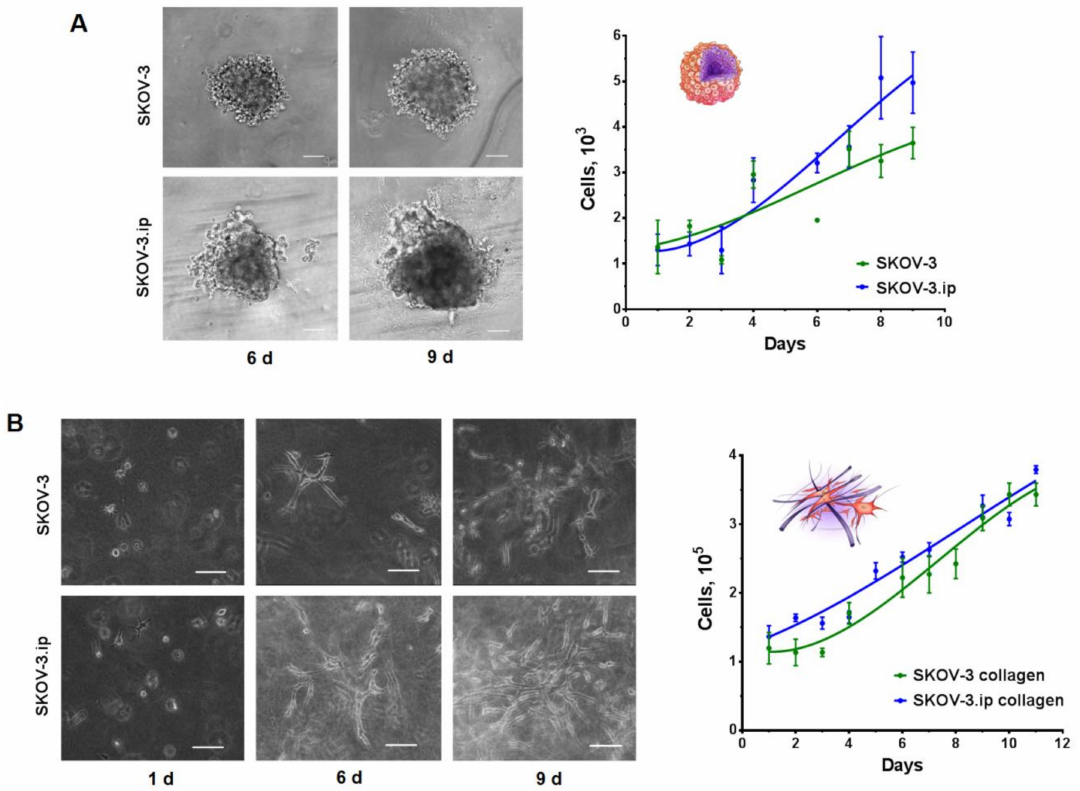
Figure 1. Growth of SKOV-3 and SKOV-3.ip cells in 3D in vitro models. ( A ) SKOV-3 and SKOV-3.ip spheroids were obtained by seeding 1000 cells / well into Ultra-low attachment round bottom plates